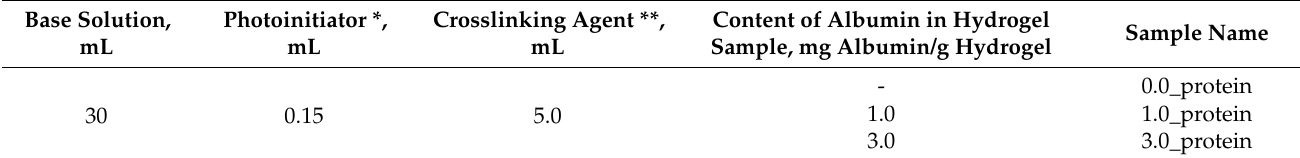
Table 3. Compositions of hydrogel materials.